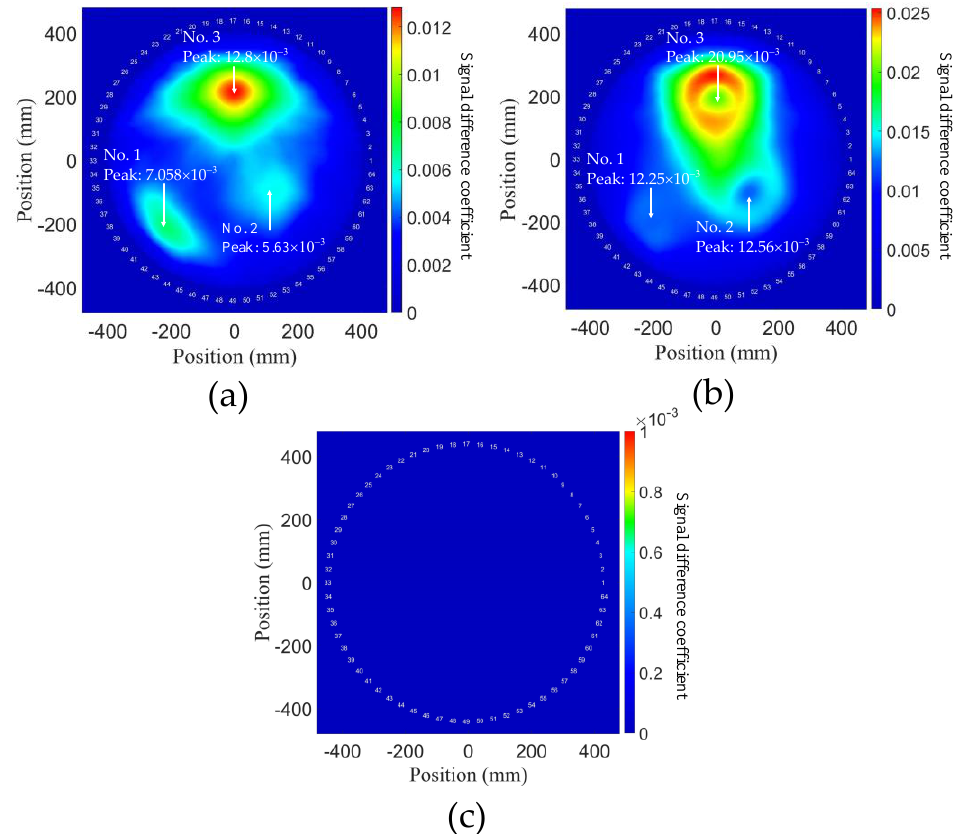
Figure 10. Probability distributions of aluminum plate model with early-life material degradations, using ( a ) attenuation method, ( b ) MP method and ( c ) covariance method.